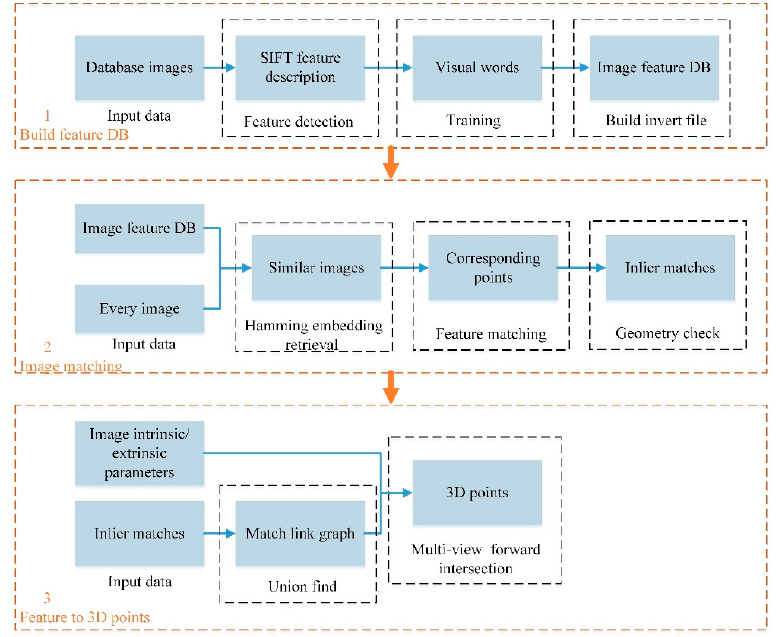
Figure 1. Workflow of database Image processing.